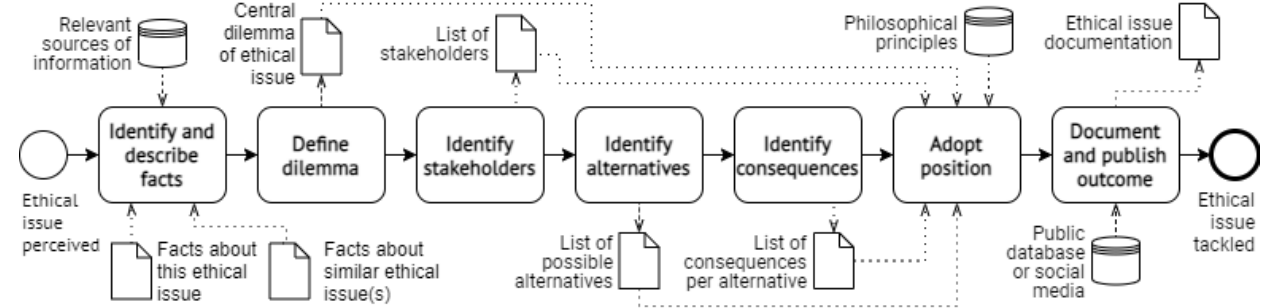
Figure 1. A process for deliberation on ethical issues (adapted from Santoro and Costa